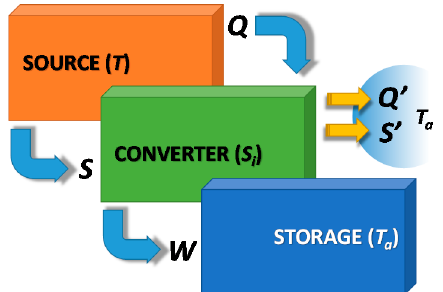
Figure 4. Indirect heat storage, charging phase.